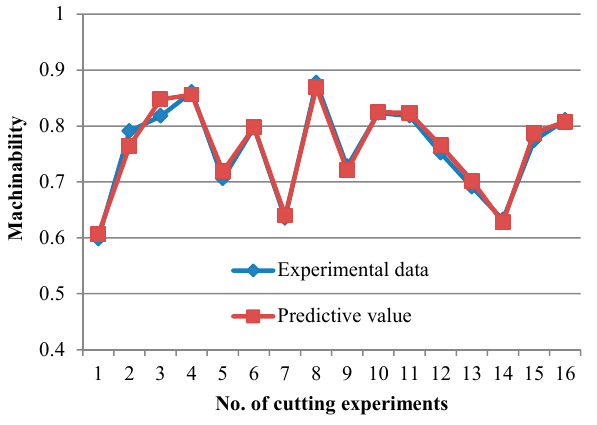
Figure 14. Comparison between the machinability evaluation results and fitting results. Table 7. ANOVA for machinability.